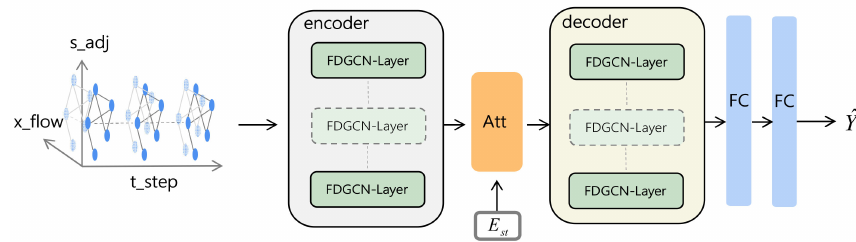
Figure 3. The framework of